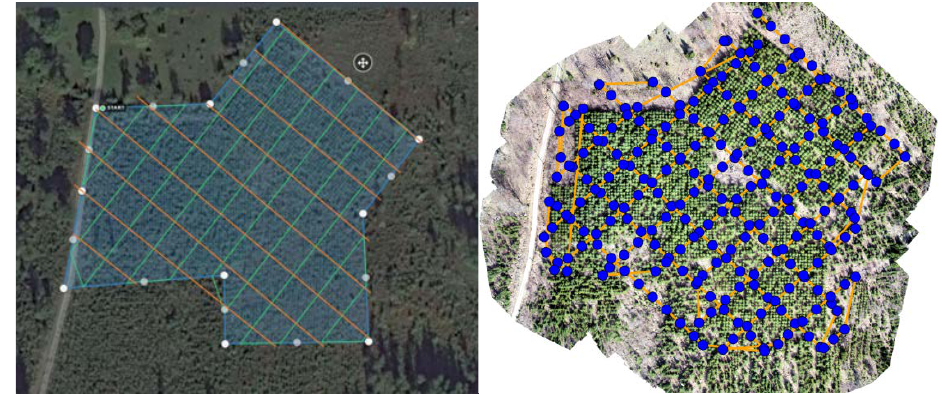
Figure 1. The trial and the flight route over the trial (green, orange—to the left ), orthomosaic created from imagery data acquired at 30 m flying height above ground. The yellow lines represent the flight paths, and the blue dots are the centers of the 251 images used as input (to the right ).